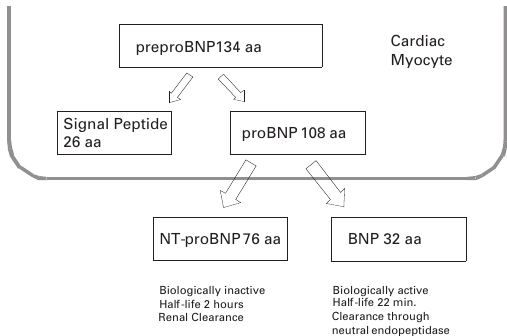
Figure 1 Intra- and extracellu- lar processing of brain natriuretic